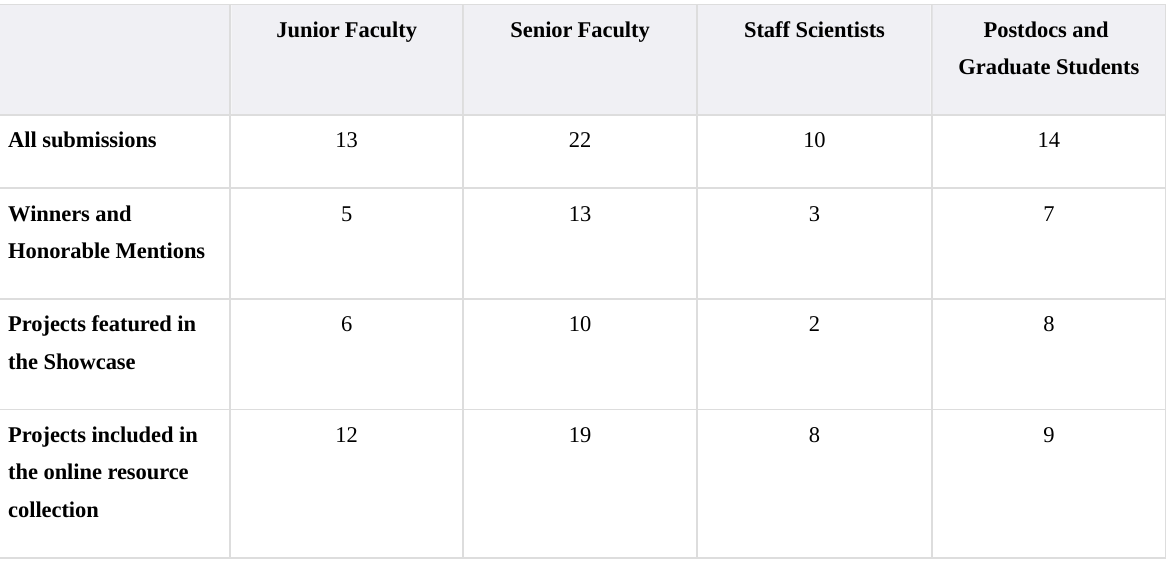
Table 2. Career stages of the University of Michigan researchers who participated in the Reproducibility Challenge.